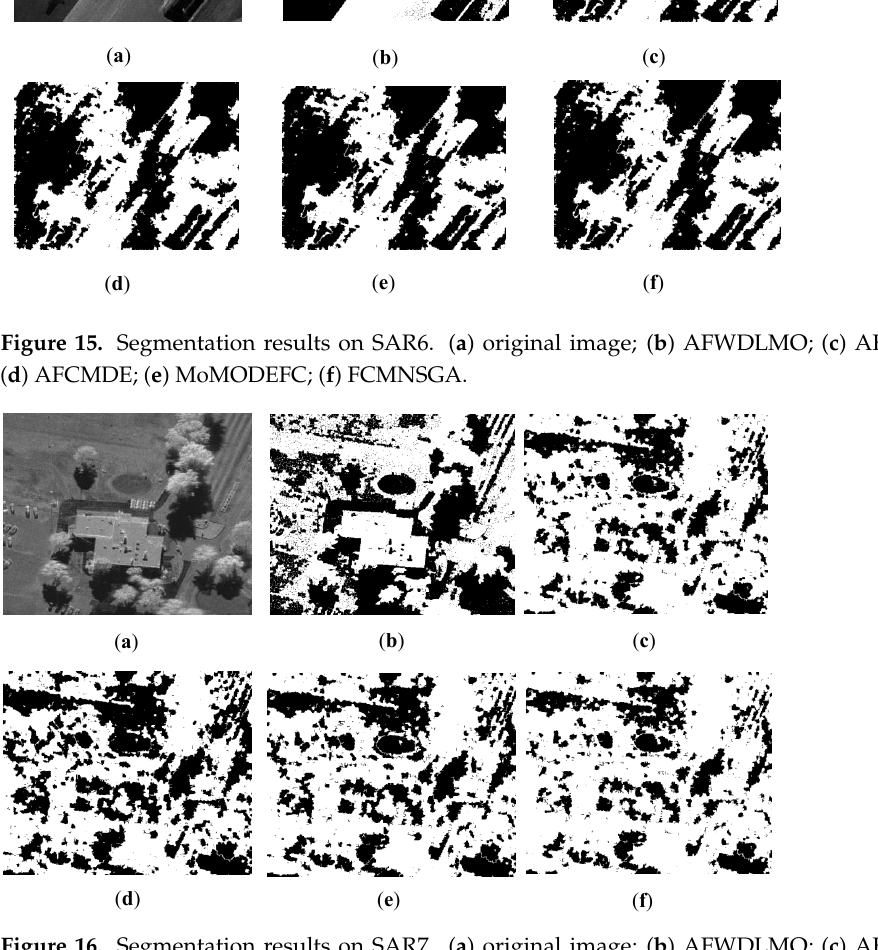
Figure 16. Segmentation results on SAR7. ( a ) original image; ( b ) AFWDLMO; ( c )